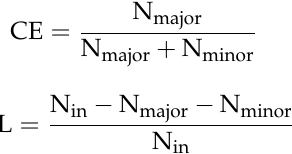
The ideal separation curve for the VI as an inertial separation device for particles is a step function. This means that when the size of the particles is larger than the cutoff diameter, they will escape from the flow line and enter the minor flow channel. When the size of the particles is smaller than the cutoff diameter, they will follow the streamline and reach the exit of the major flow channel. In the VI design, the particle Stokes number is defined as the ratio of the particle stopping distance to the characteristic length (a dimensionless parameter) and is used as an indicator of particle behavior in the virtual impactor [24].